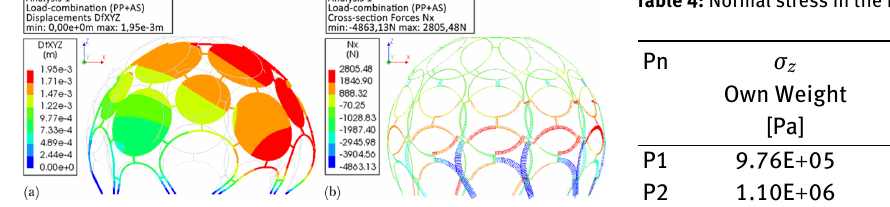
Figure 17: Bending moment diagrams: self-weight and snow (Case 1) (a); self-weight and seismic acceleration (Case 2) (a) Table 4: Normal stress in the most critical cross